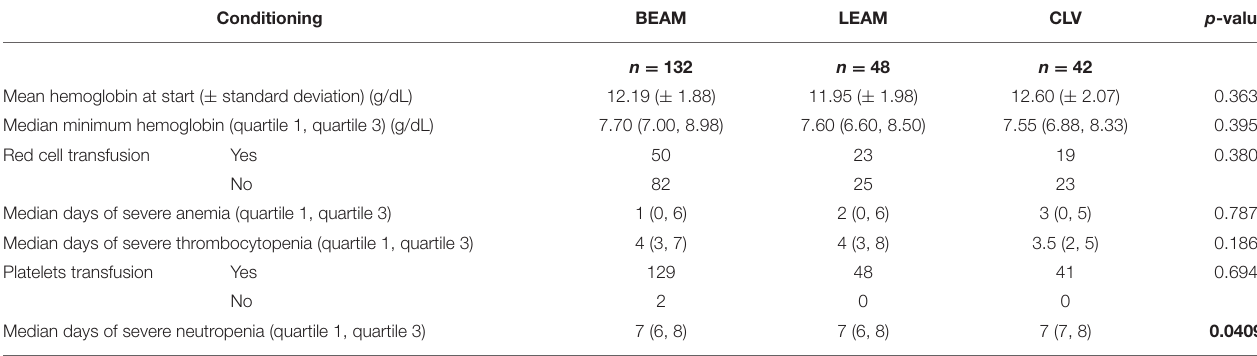
TABLE 3 | Hematological toxicities following conditioning chemotherapy. Conditioning BEAM LEAM